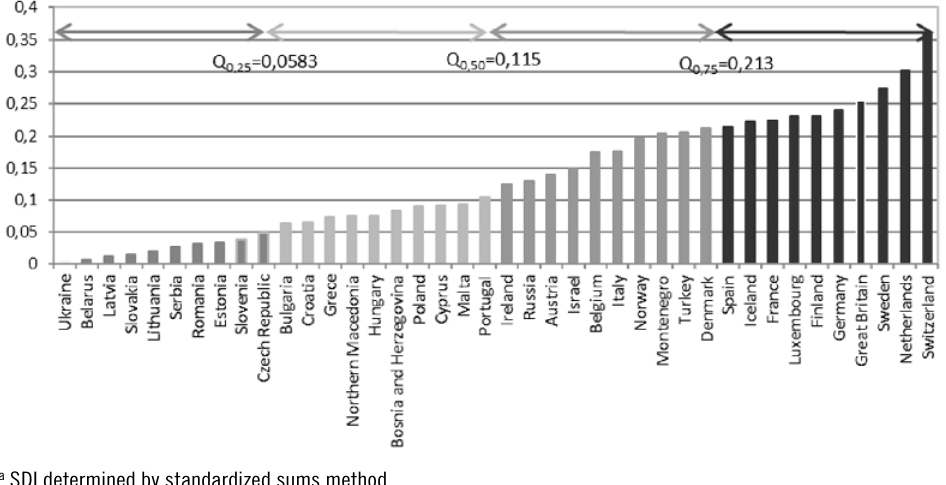
Figure A3.1. Ranking of exchanges according to the level of development measured by alternative value of SDI a